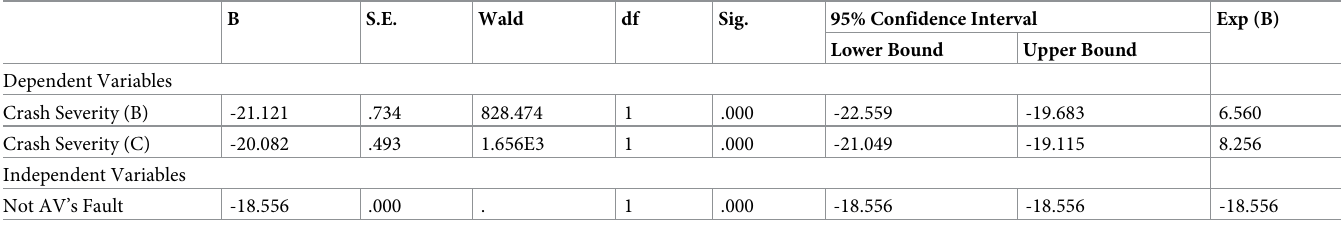
Table 3. Ordinal logistic model results for crash severity (conventional